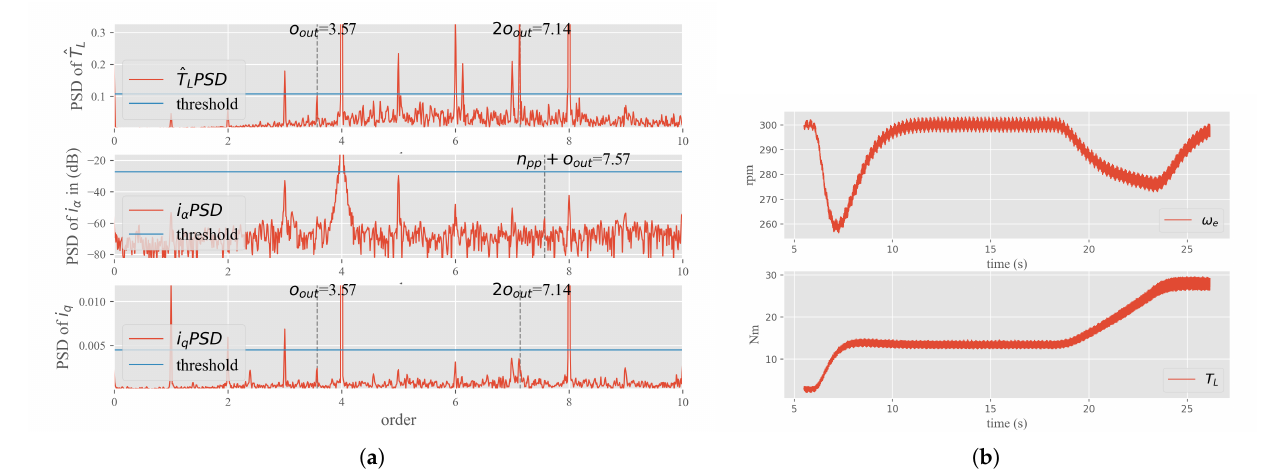
Figure 10. Torque varying experiments (Case1) of the bearing fault motor ( a ) power spectrum density and ( b ) graphical transients of speed and torque.